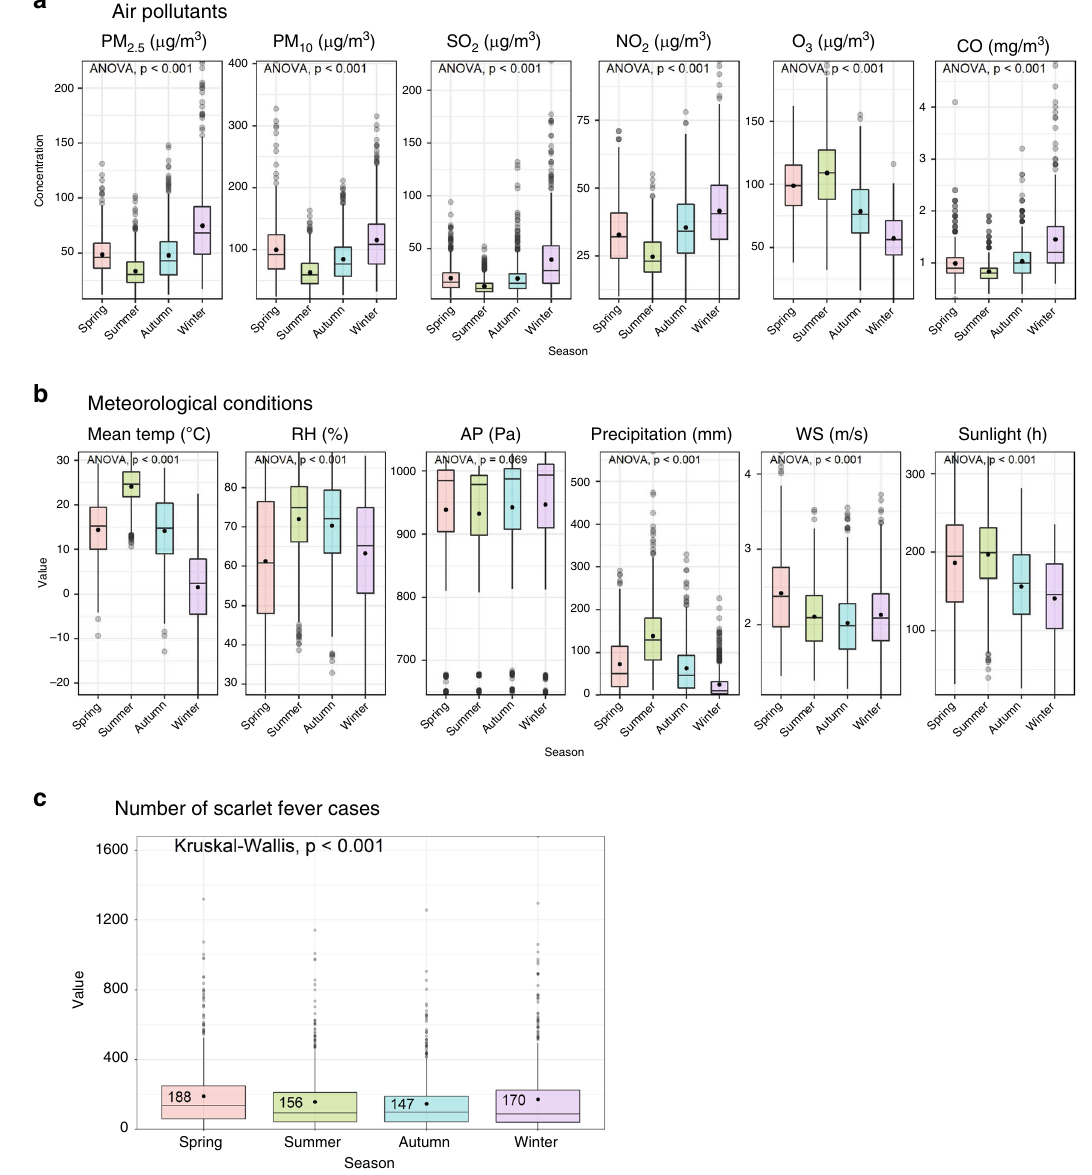
Fig. 2 Boxplots of six air pollutants, six meteorological conditions and the number of scarlet fever cases in four seasons from 2013 to 2018. a The seasonal pattern of air pollutants. b The seasonal pattern of weather conditions. c The seasonal pattern of scarlet fever. An analysis of variance (ANOVA) test is applied to examine the values or concentrations among the four seasons. A Kruskal – Wallis test is used to examine the scarlet fever incidences among the four seasons: spring (March to May), summer (June to August), autumn (September to November), and winter (December to February). PM 2.5 particulate matter with aerodynamic diameter <2.5 μ m. PM 10 particulate matter with aerodynamic diameter <10 μ m, SO 2 sulfur dioxide, NO 2 nitrogen dioxide, O 3 ozone, CO carbon monoxide, Mean Temp mean temperature, RH relative humidity, AP air pressure, WS wind speed. Source data are provided as a Source Data fi